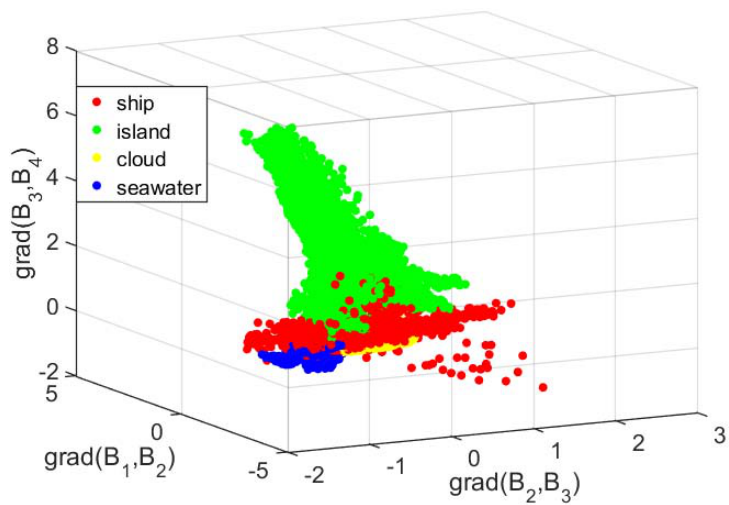
Figure 5. The 3-dimensional reflectance gradient values of seawater, clouds, islands, and